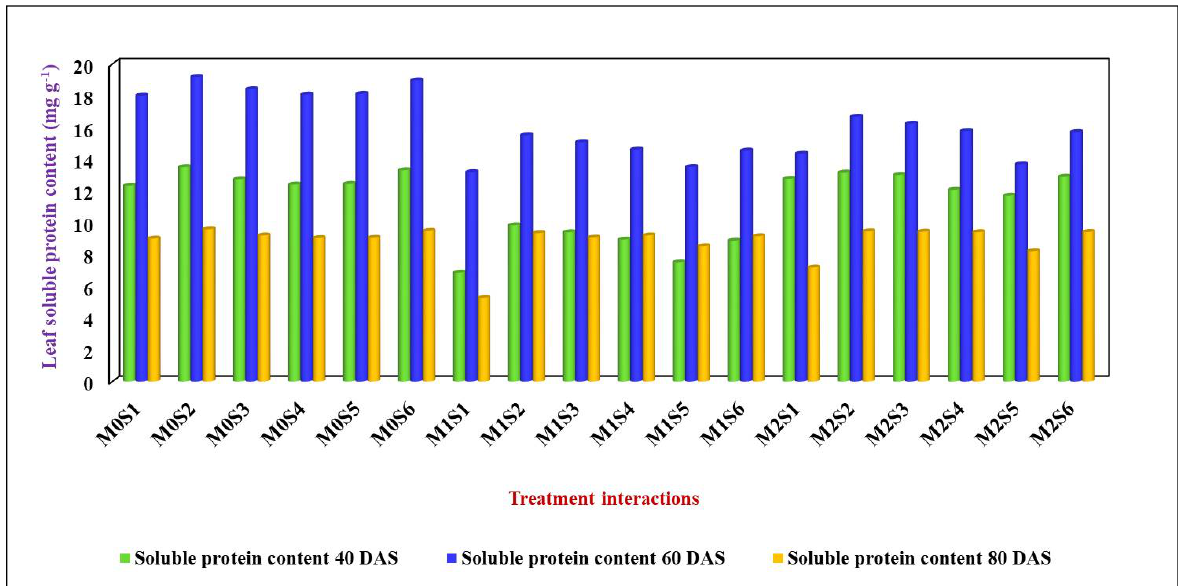
Figure 1: Effect of plant growth regulating chemicals on leaf soluble protein content (mg g –1 ) of bhendi hybrid CO under moisture stress 4